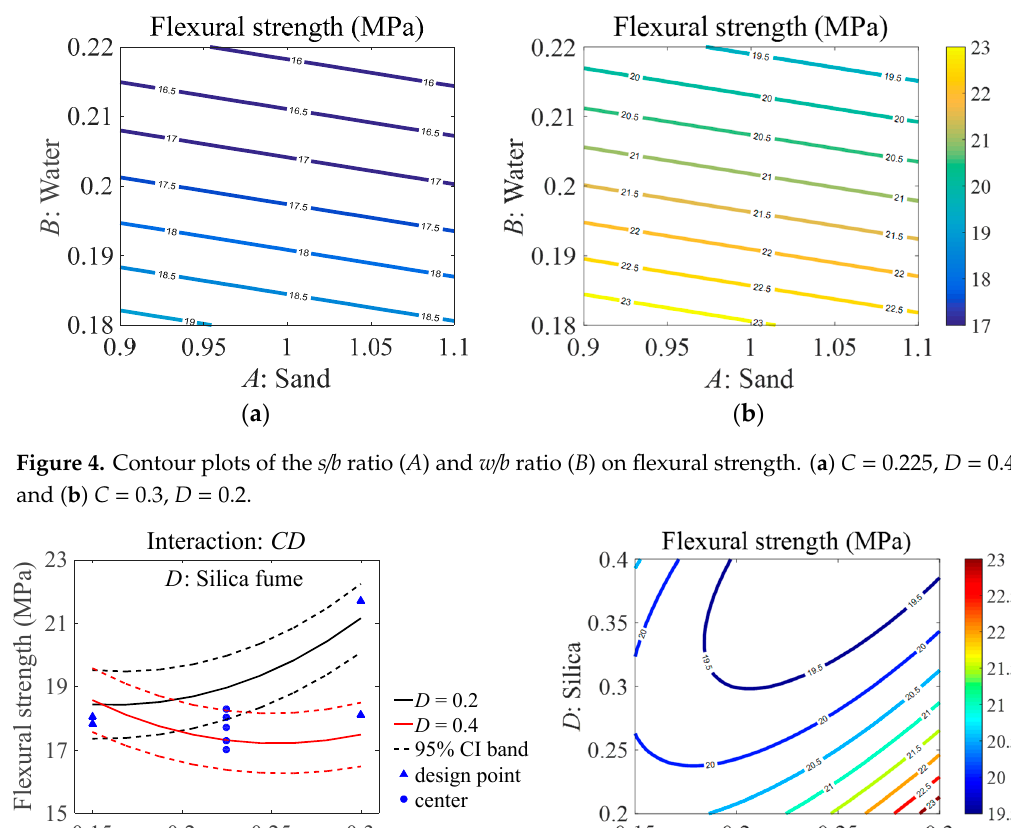
Figure 4. Contour plots of the s/b ratio ( A ) and w/b ratio ( B ) on flexural strength. ( a ) C = 0.225, D = 0.4 and ( b ) C = 0.3, D = 0.2.